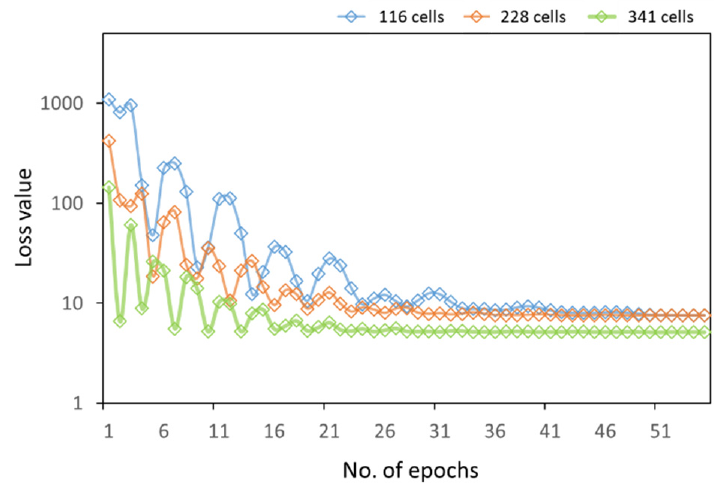
Figure 11. Loss of predictive value versus the number of epochs.